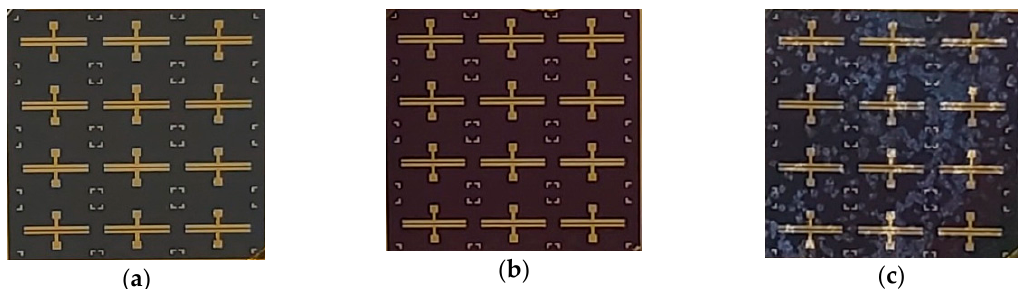
Figure 2. 3D structure of the MSM and metal-oxide-semiconductor-oxide-metal (MOSOM) varactors.